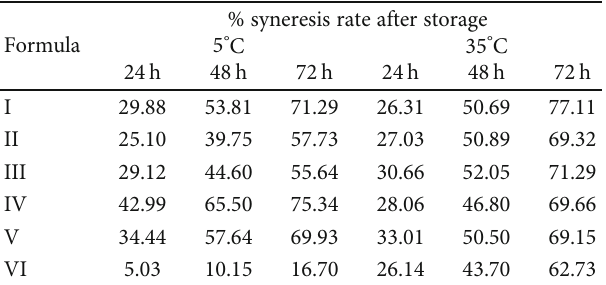
Table 5: Syneresis rate of air freshener gel formulation during storage time